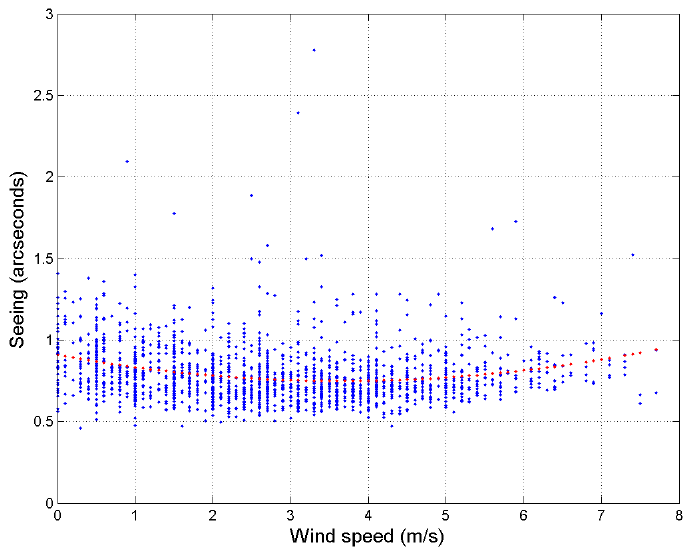
Figure 6. Seeing versus wind speed.